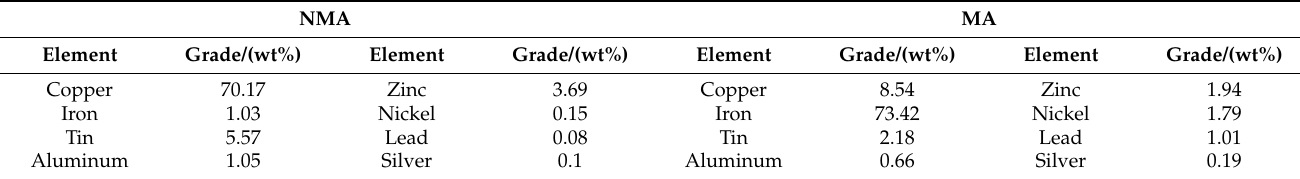
Table 9. The elements distribution of NMA and MA of high-gradient magnetic